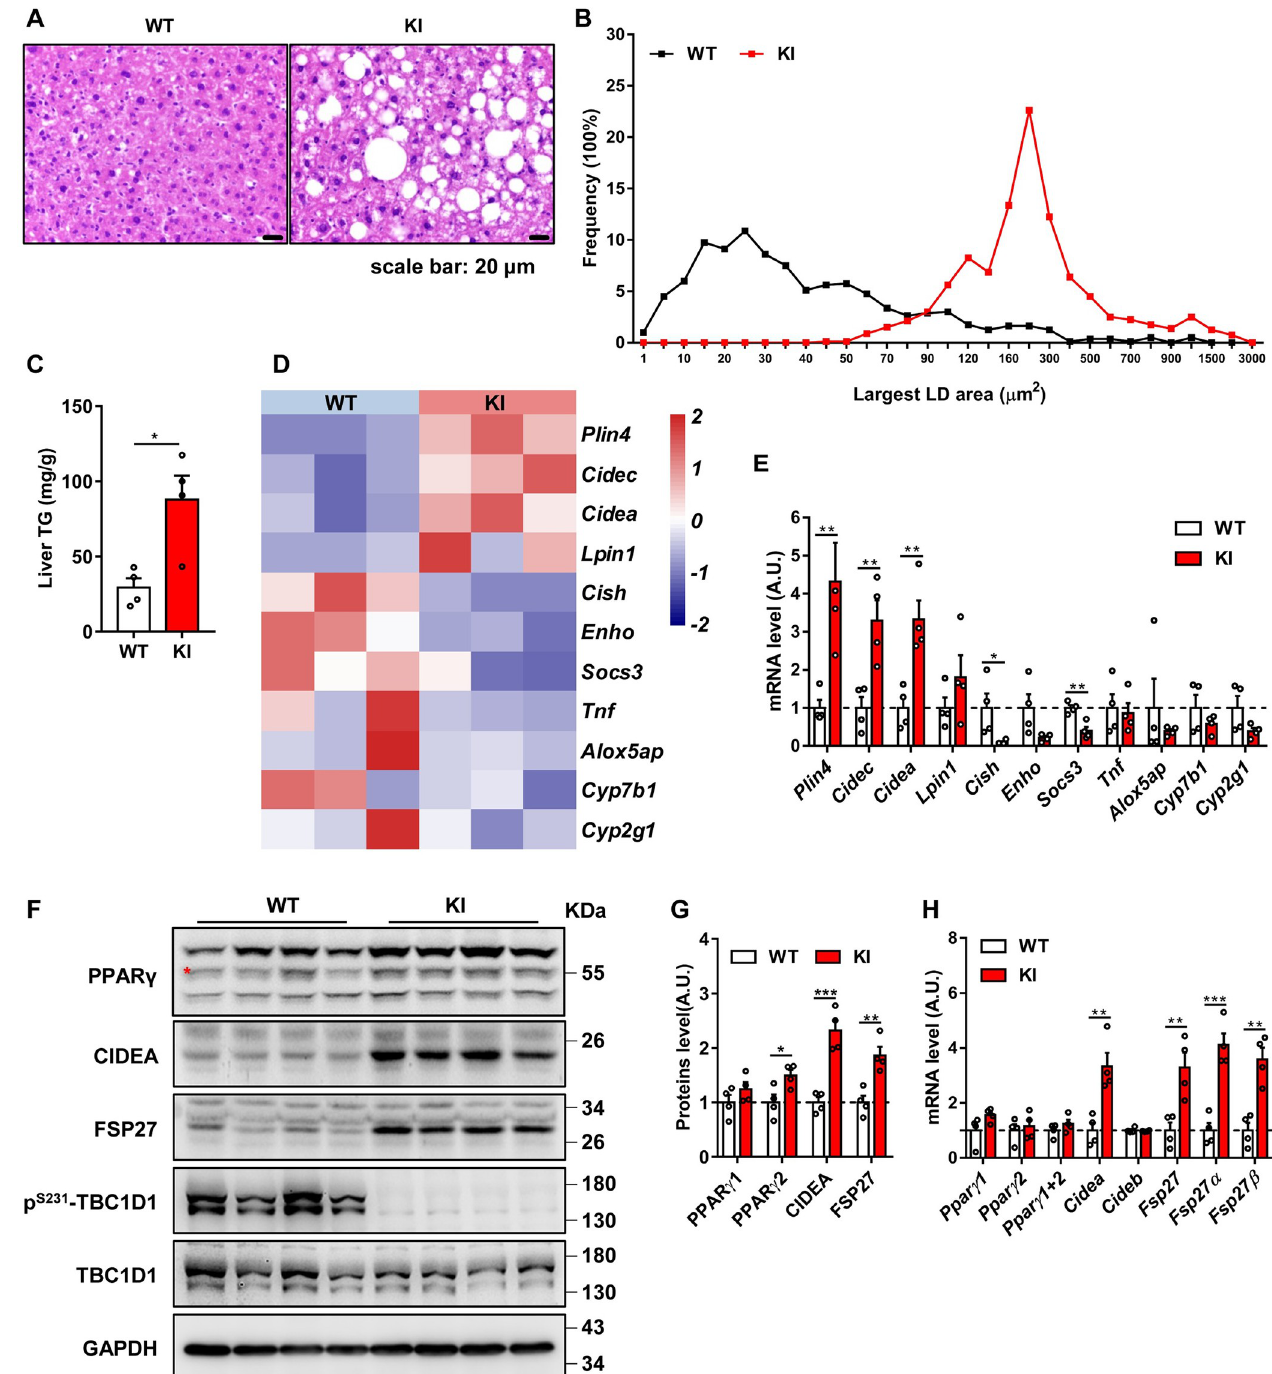
Fig 1. Blocking the AMPK-TBC1D1 axis in aged mice leads to hepatic lipid accumulation. (A) Hematoxylin–eosin staining of liver sections from WT and TBC1D1 KI male mice aged 18 months (random feed, n = 4 per group). Representative images are shown. (B) Size profiles of lipid droplets in liver sections (A). At least 200 droplets from each mouse were assessed. The percentages of lipid droplets of various sizes are shown. (C) TG levels in the livers of WT and TBC1D1 KI male mice aged 18 months (random feed, n = 4 per group). (D) Heatmap shows the genes with significant differences in expression between the livers of WT and TBC1D1-KI male mice at 18 months of age based on RNA sequencing data (random feed, n = 3 per group). (E) mRNA expression levels of genes in the heatmap were confirmed by Q-PCR (random feed, n = 4 per group). (F) Increased protein level of PPAR γ in the liver of TBC1D1-KI mice aged 18 months. The data were obtained by immunoblotting (random feed, n = 4 per group). The red asterisk indicates nonspecific signal. (G) Statistical analysis of protein levels shown in F. (H) mRNA expression levels of PPAR γ -related genes were confirmed by Q-PCR (random feed, n = 4 per group). The data were